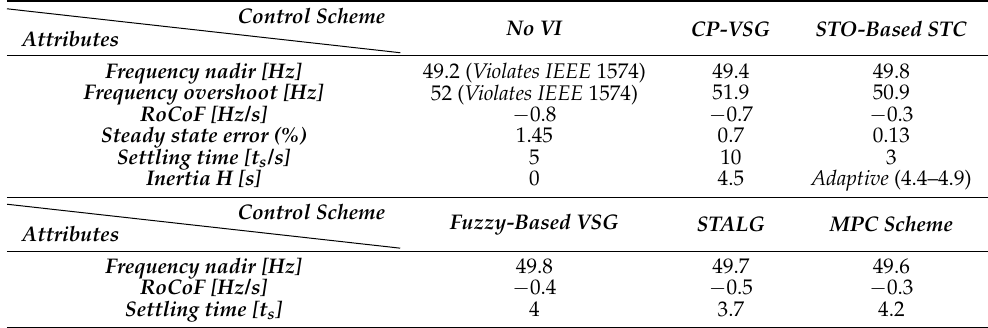
Table 3. Performance evaluation and comparison on sudden load